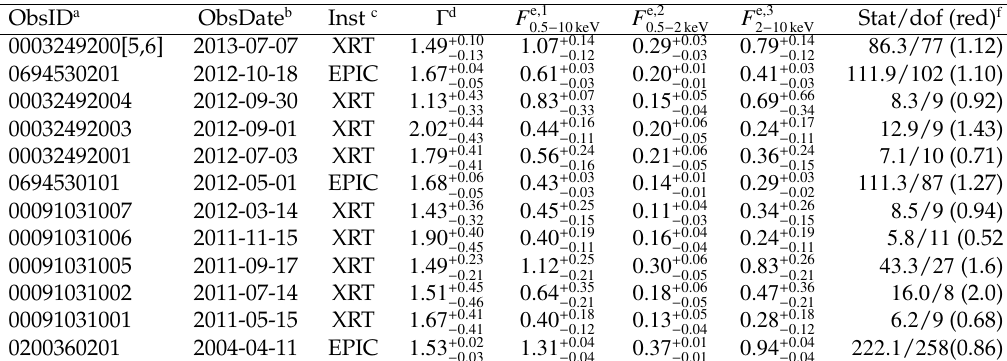
Table 1. Results of the absorbed powerlaw fit to the X-ray